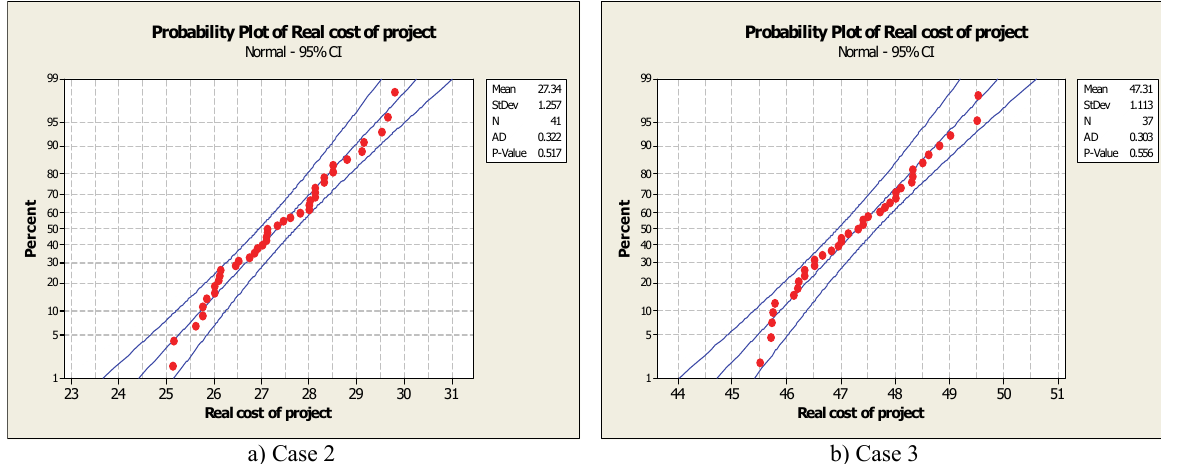
Fig. 8 demonstrates the probability plot for the data of true cost fitting on Normal distribution for two cases (to decrease the paper's size, the plot is shown for just two cases).